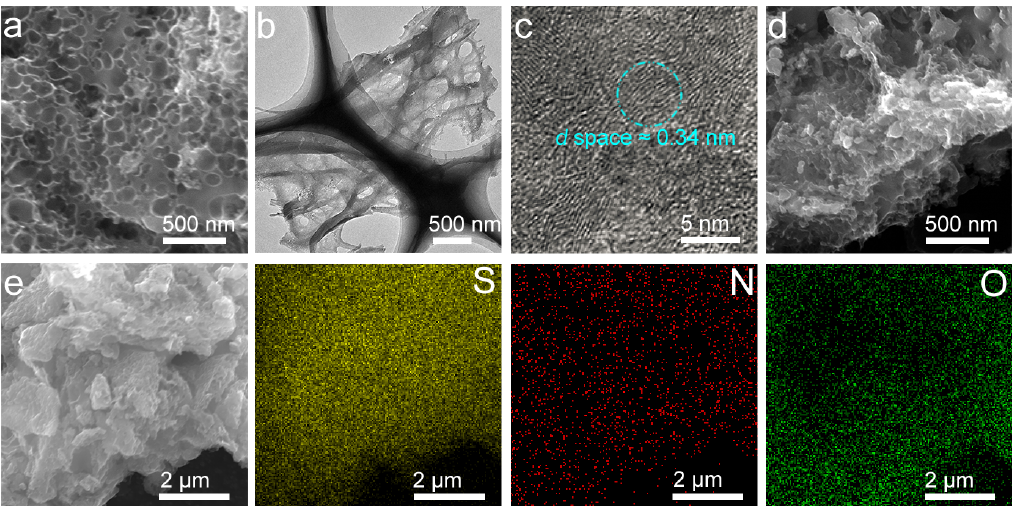
Figure 2. ( a – c ) Scanning electron microscopy SEM ( a ) and bright field transmission electron microscopy (TEM) images ( b , c ) of the MPC; ( d ) SEM image of the S@MPC; ( e ) the SEM and corresponding S, N, and C mappings of the S@MPC.